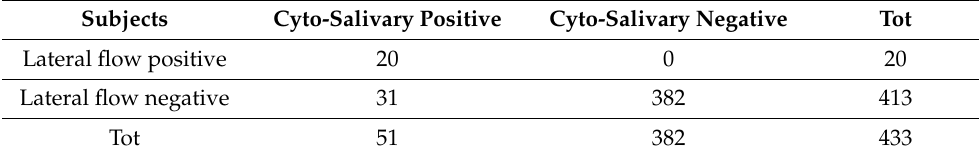
Table 3. Results of the screening of the lateral flow test compared with cyto-salivary antigen test.